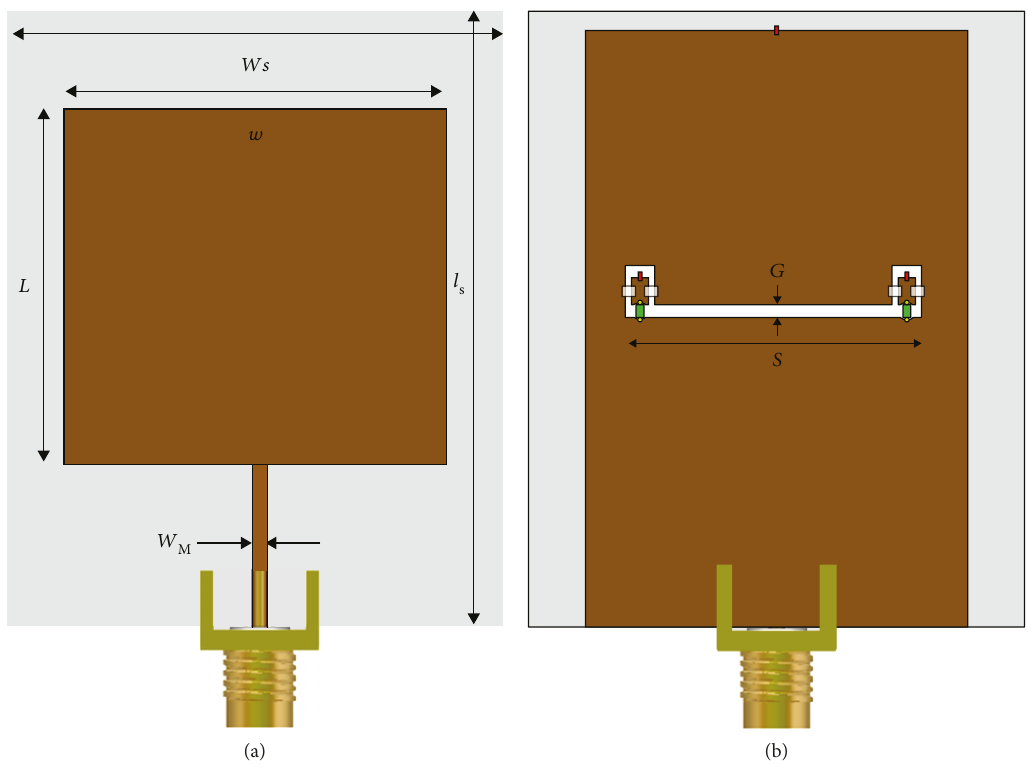
Figure 7: Antenna geometry. (a) Front view. (b) Back view. Table 1: Dimension of the designed